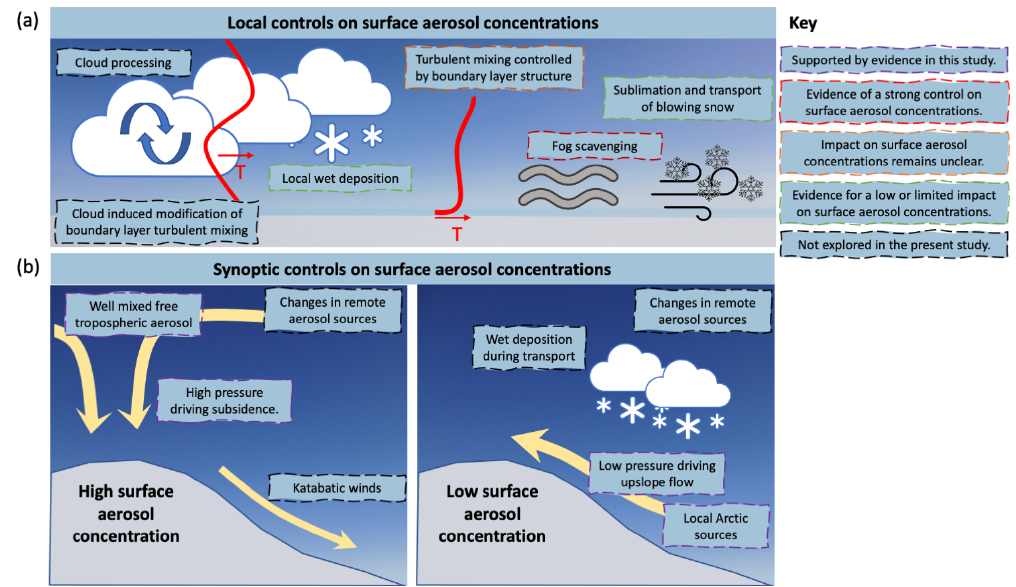
Figure 16. Conceptual model illustrating the key components controlling surface aerosol particle concentrations over the central GrIS, highlighting factors that are supported by evidence in this study and important areas for future research (see legend